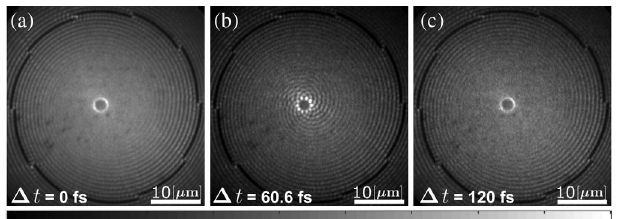
FIG. 7. Measured PEEM snapshots of an l ¼ 9 vortex inter- acting with a σ ¼ − 1 light field . The snapshots show time delays of (a) Δ t ¼ 0 fs (early), (b) Δ t ¼ 60 . 6 fs (revolving) and (c) Δ t ¼ 120 fs